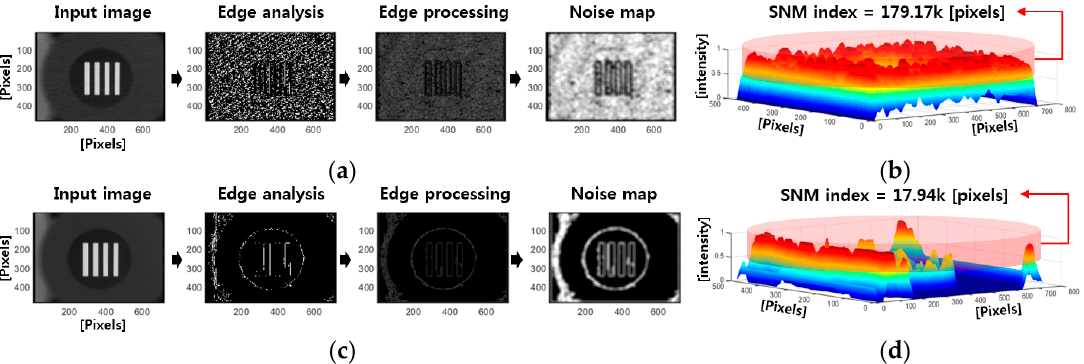
Figure 7. Measurement of noise map of an MWIR image using SNM: ( a ) noisy image; ( c ) noise-filtered image; ( b , d ) SNM measurement results.